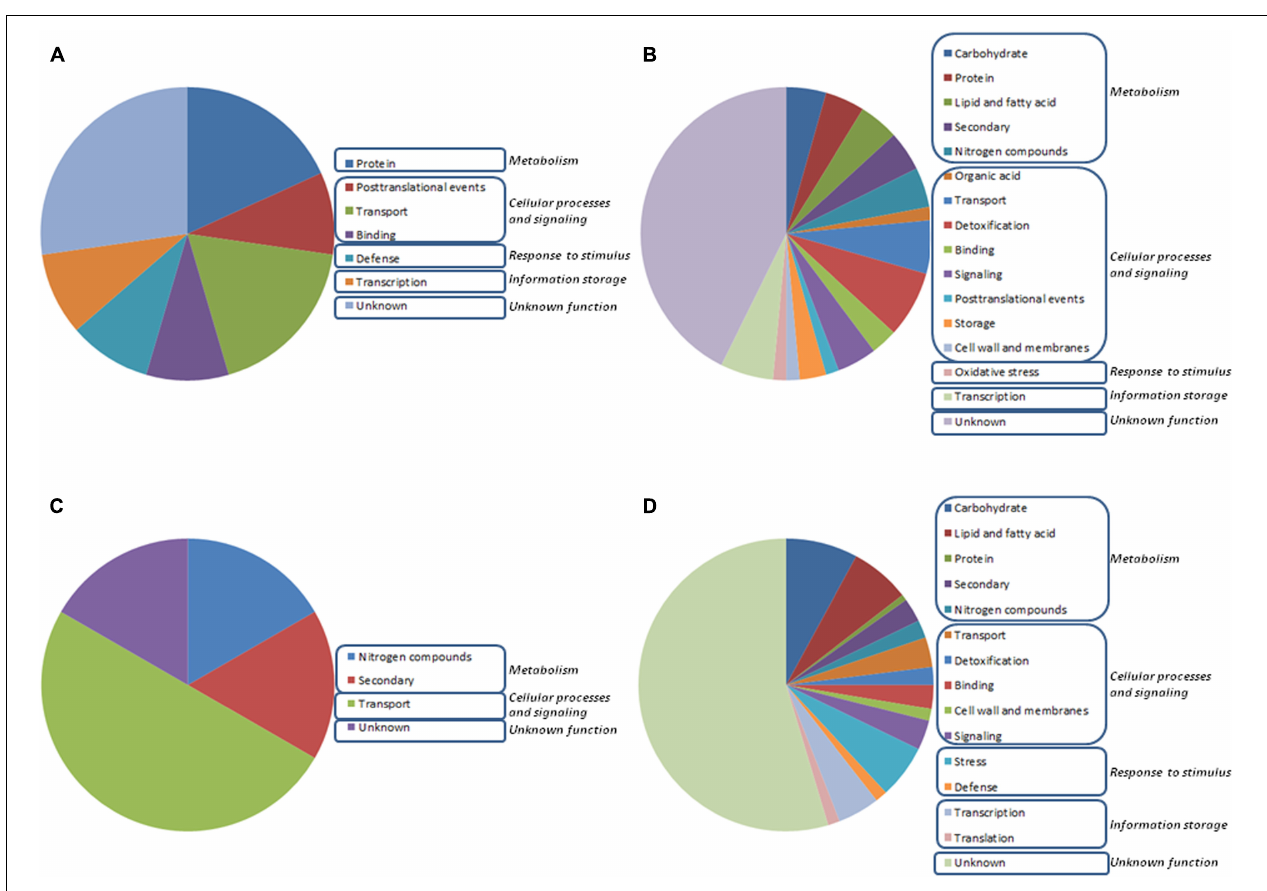
FIGURE 1 | Distribution within physiological processes of the 226 differentially expressed genes at early stage (48 h growth) in wheat seedling roots resulting from the GeneChip Wheat Genome Array analysis is depicted for eight different growth conditions with (T1) or without (T0) Trichoderma harzianum T34 and 0 (N0), 0.1 (N0.1), 0.5 (N0.5) or 1 (N1) mM calcium nitrate. Gene significance was assigned to at least twofold change ( P : 0.15). Comparisons were performed between (A) T0N0 and T0N0.5 or T0N1, (B) T0N0 and T1N0, (C) T1N0 and T1N0.5 or T1N1, and (D) T0N0.1, T0N0.5 or T0N1 and T1N0.1, T1N0.5 or